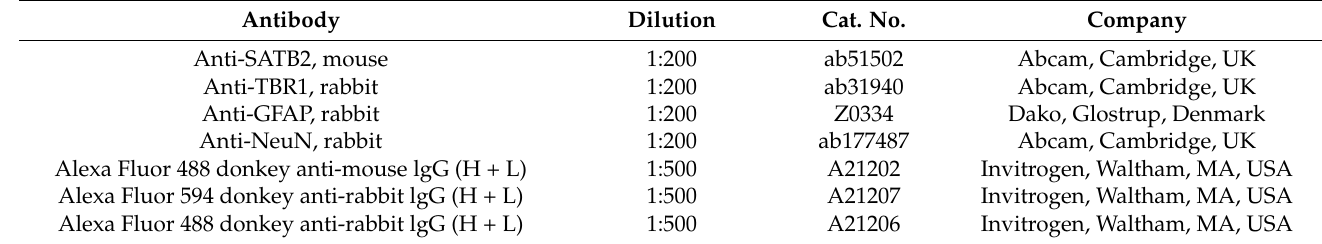
Table 1. Antibodies used in the